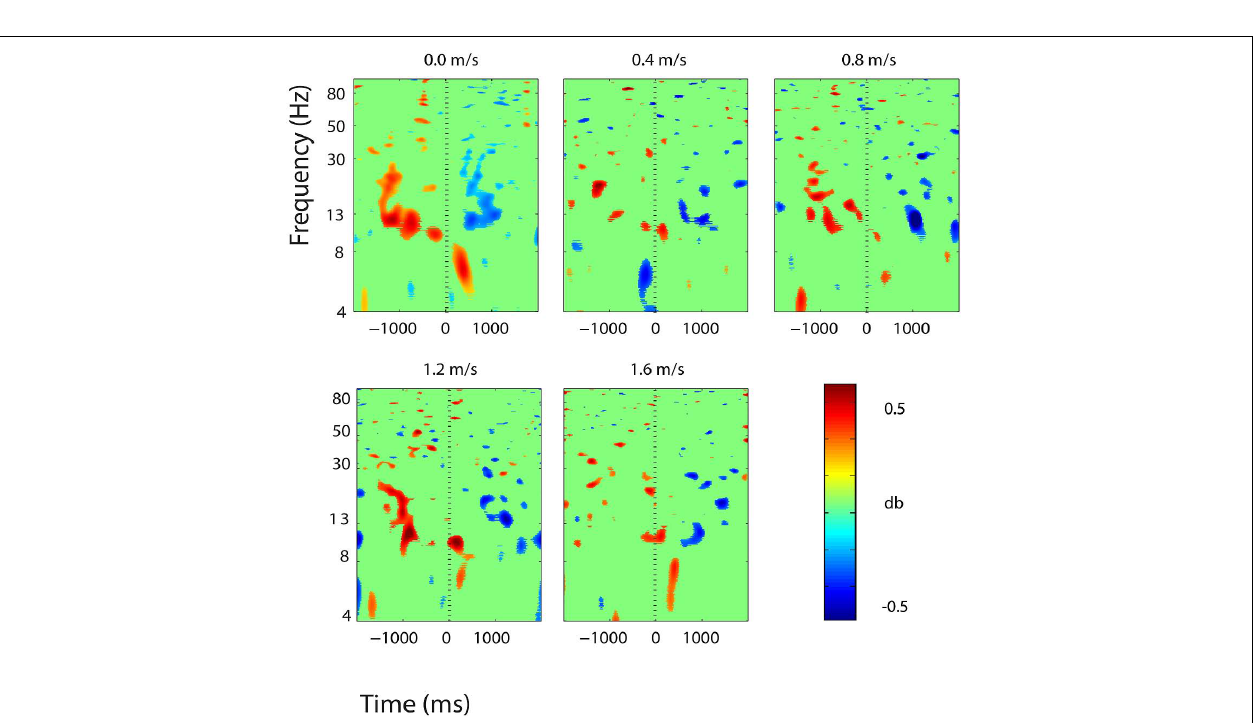
superior parietal lobule (BA 5), and yellow is the central premotor and supplementary motor cortex (BA 6). From left to right, the top three images show the centroid locations for each cluster from a horizontal, coronal, and sagittal view. The bottom three images show the independent component dipoles for each cluster from the same three perspectives.